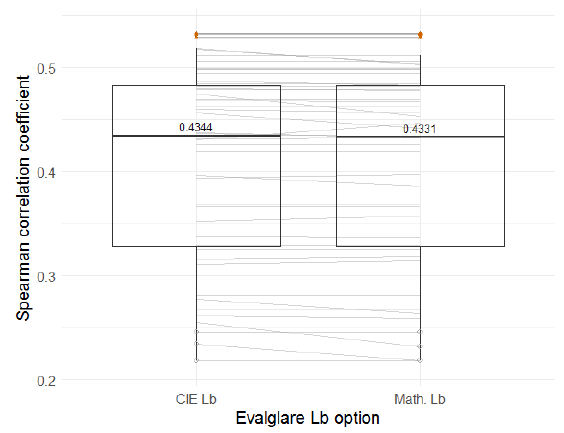
Figure 12. Boxplots of Spearman rho for the two background luminance definitions (field study).